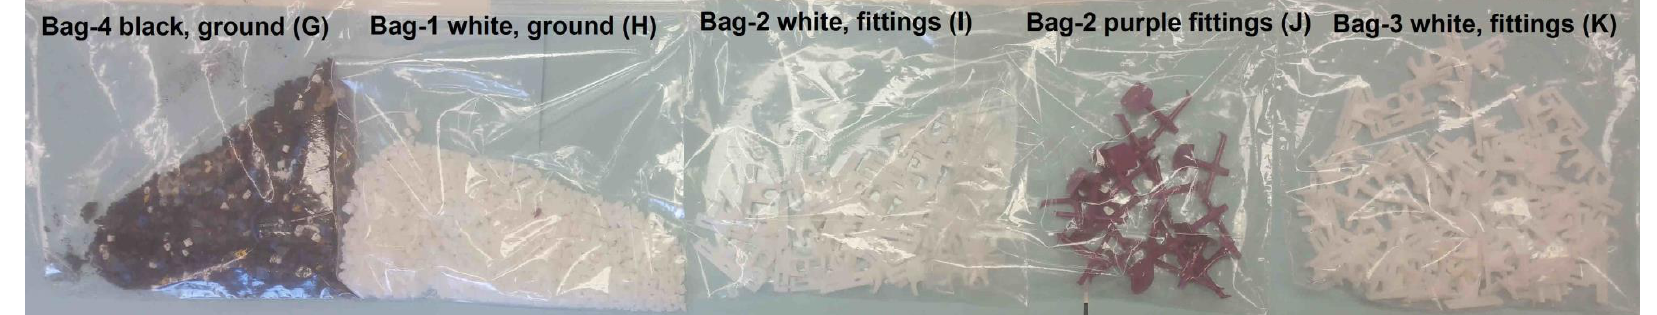
Figure 6. E-plastics samples ( G–K ) analyzed by hand-held XRF (see Tables 1 and S1).